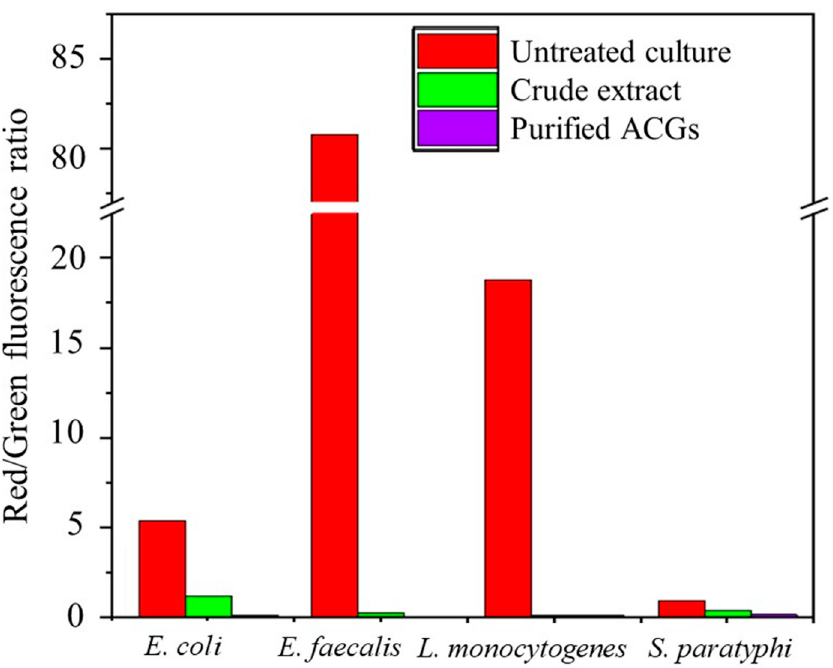
Figure 3. The membrane potential of pathogenic bacterial strains treated and untreated with antibacterial extracts.